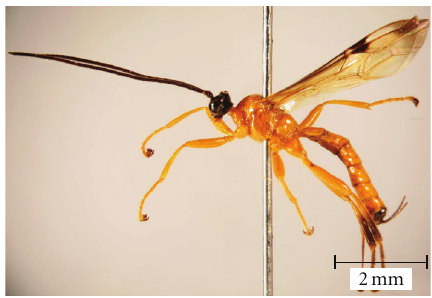
Figure 5: Habitus of T. vilmae , paratype female (BMNH).